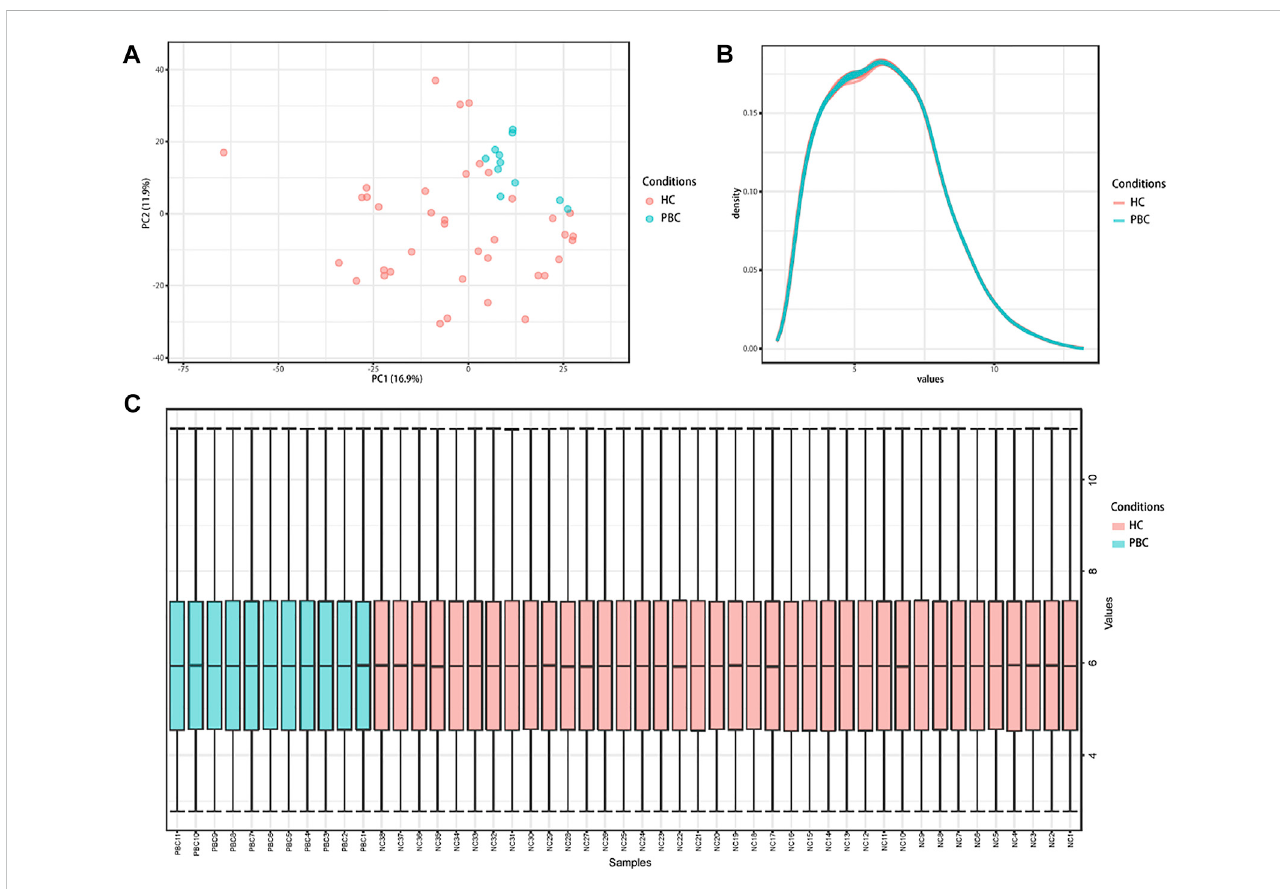
FIGURE 1 Distributionfeaturesoftheexpressionsituationofsamplesafternormalization. (A) PCAshowsthedistributionofexpressionvaluesofallsamples. (B) The density curveof all samples. (C) Boxplot comparing expression valuesof all samples. PCA, principal component analysis; PBC,Primary biliary cholangitis; HC, healthy